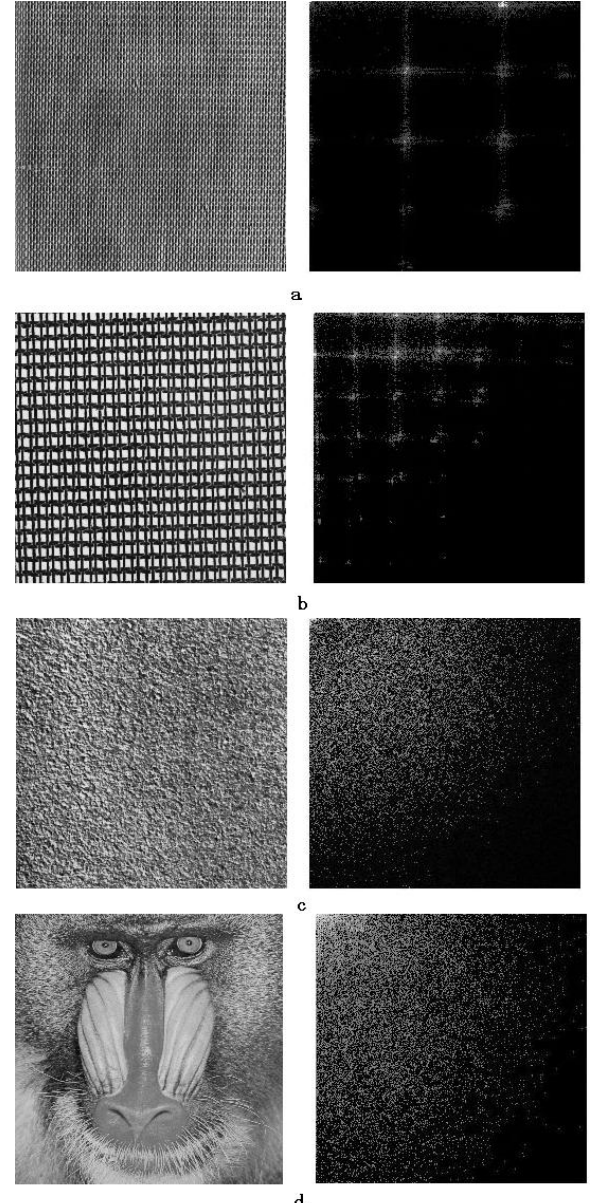
Fig 6. Energy compaction of